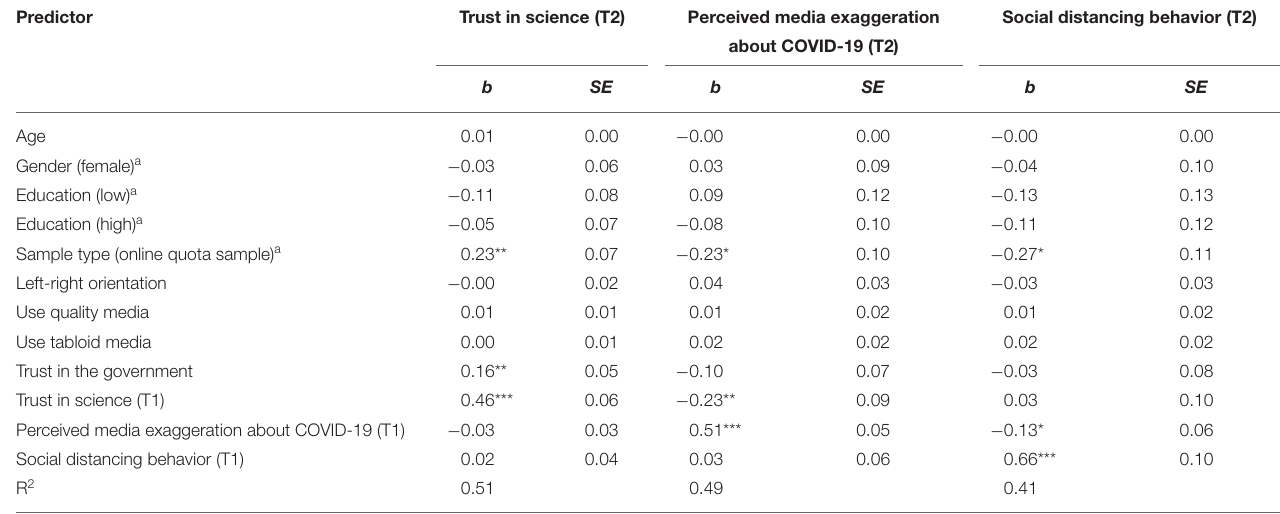
TABLE 2 | Results of the structural equation model.